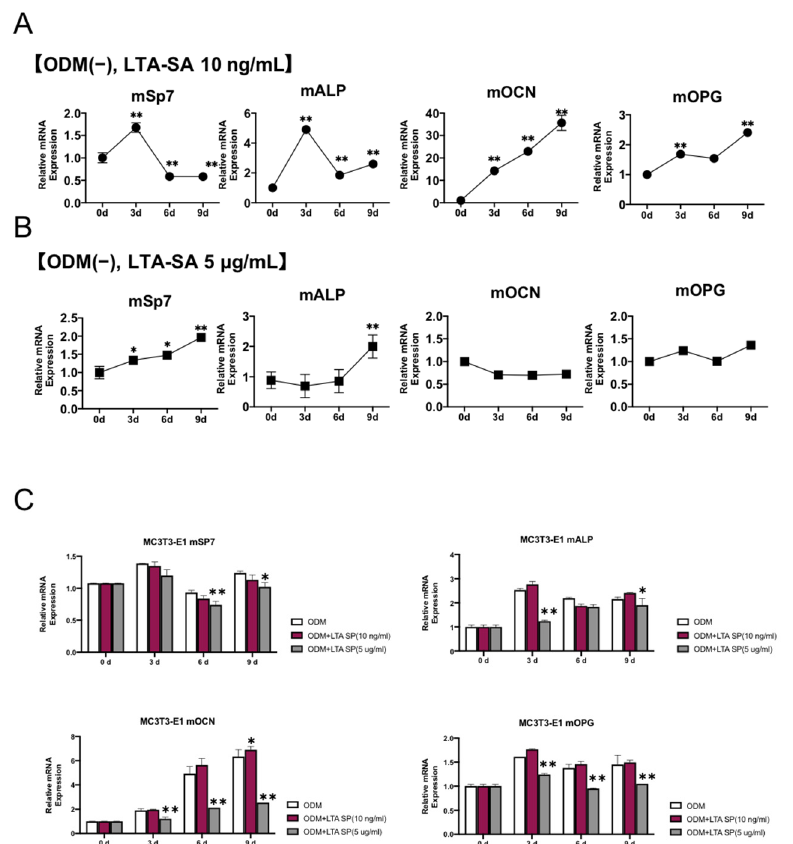
Figure 3. Effects of LTA on MC3T3-E1 osteogenesis-related markers. ( A , B ) Expression of osteogenic marker genes in MC3T3-E1 cells cultured in non-osteogenic induction medium supplemented with LTA (10 ng/mL or 5 µ g/mL) for the indicated times. At 10 ng/mL, Sp7 and ALP showed a significant temporary increase in expression, and OCN and OPG showed a time-dependent increase in expression until day 9. A value of 5 µ g/mL showed an increase in Sp7 and ALP on day 9, but no change in OCN and OPG expression. ( C ) Expression of osteogenic marker genes in MC3T3-E1 cultured in osteogenic induction medium supplemented with LTA (10 ng/mL or 5 µ g/mL) for the indicated times. In the osteogenic induction medium, the addition of LTA did not enhance the expression of osteogenesis- related markers. At 5 µ g/mL, the expression of SP7 on days 6 and 9, ALP on days 3 and 9, and OCN and OPG on all measurement days were suppressed. ALP—alkaline phosphatase; OCN—osteocalcin; OPG—osteoprotegerin. Results are presented as means ± S.D. * p < 0.05, ** p <